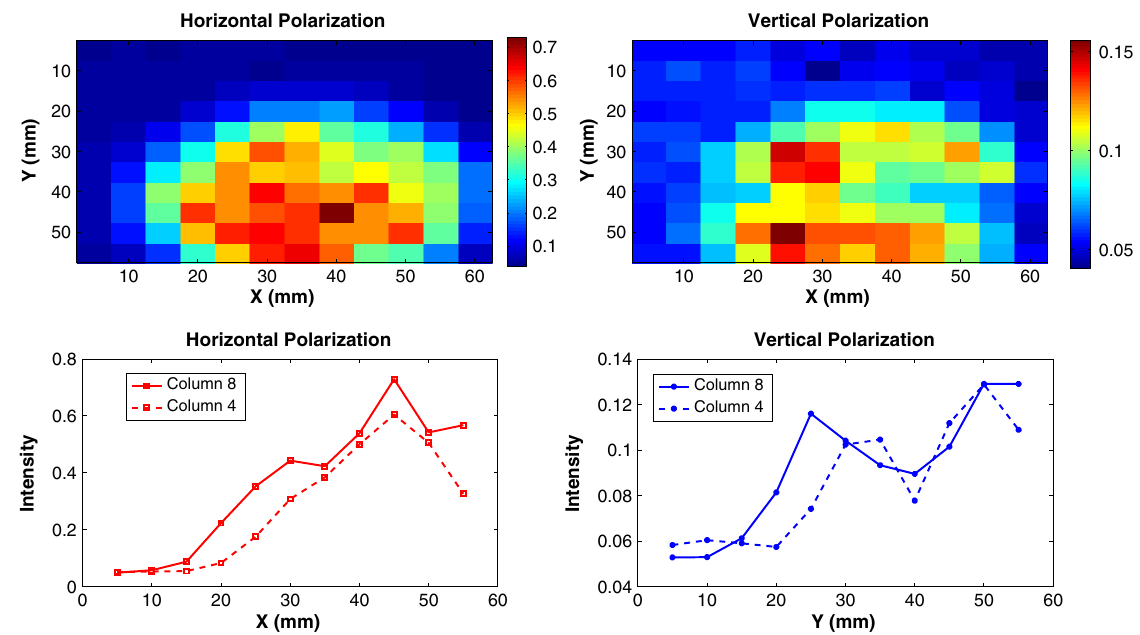
FIG. 5. Top: Measured angular distribution of the CSR radiation with horizontal polarization (left) and with vertical polarization (right). Bottom: Two slice projections from the spatial distribution showing the angular distribution of the coherent synchrotron radiation. The horizontal polarization (left) shows a maximum at the center—a single lobe, while the vertical polarization (right) shows a dip in the center—a double-lobed feature. Note: the scales are different by a factor of (cid:6) 5 indicating higher intensity of the horizontally polarized synchrotron